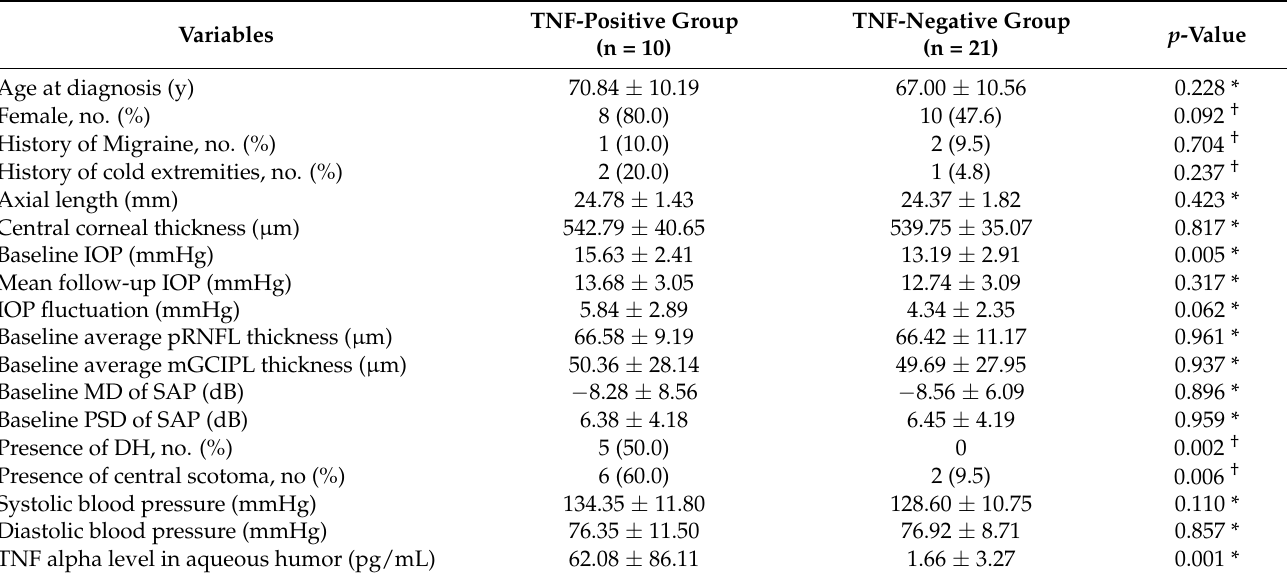
Table 4. Comparison of baseline characteristics between TNF- α -positive and TNF- α -negative normal tension glaucoma